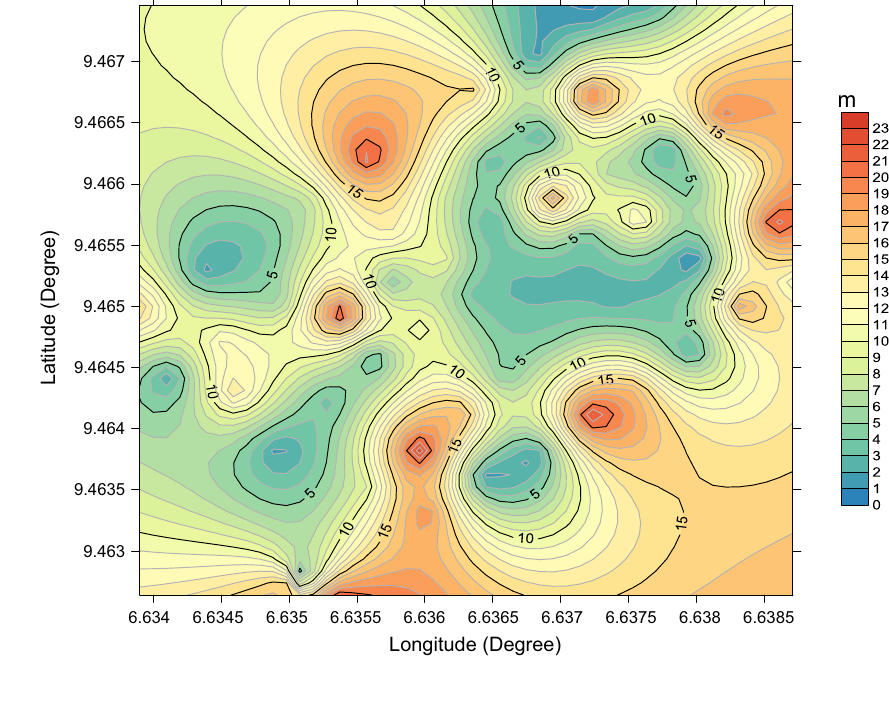
Fig. 7 Isopach map of the frac- tured